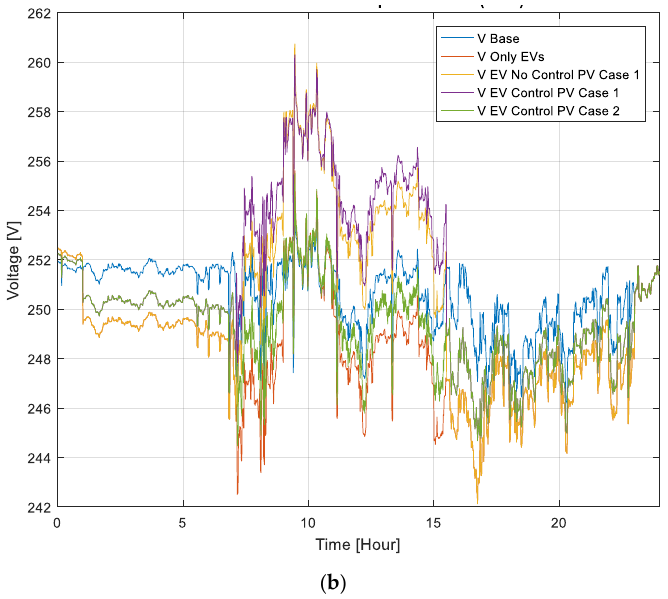
Figure 11. Test cases: ( a ) substation power and ( b ) busbar voltage for client 349.